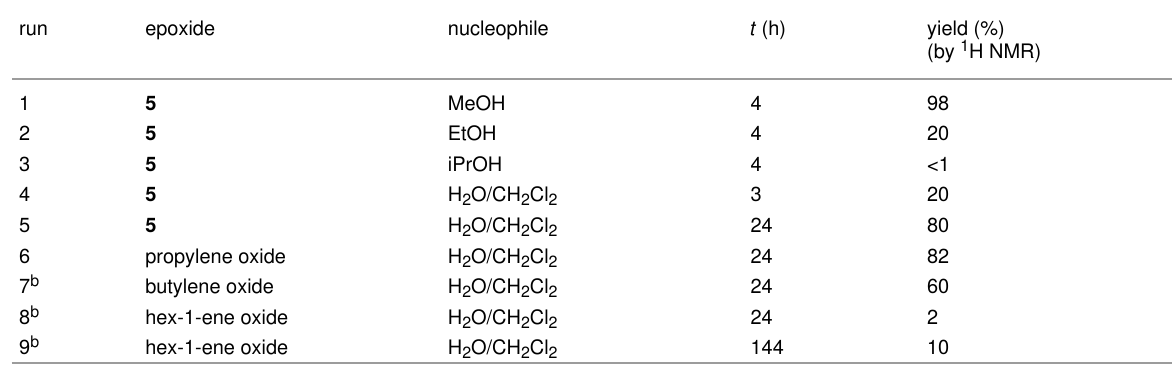
Table 2: Ring opening of epoxides by water or alcohols promoted by F-1 at room temperature. a